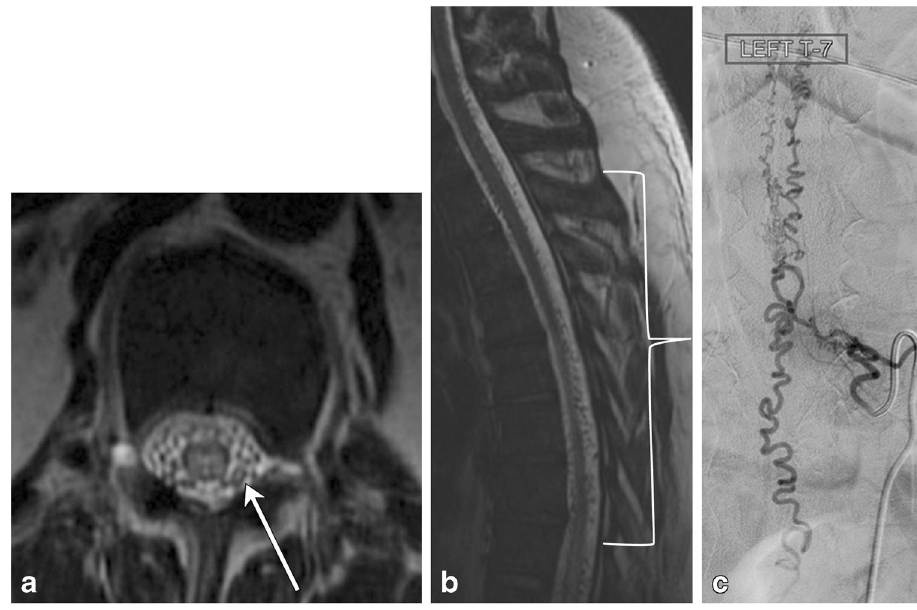
Fig. 18 Dural arteriovenous fistula. A 50-year-old male with gradual onset of inability to walk, off and on constipation, and uri- nary incontinence. a Axial T2 image demonstrates hyperintensity in the cord and multiple serpiginous flow voids (arrow) within the thecal sac. b Sagittal T2 image reveals long segment involvement (bracket). c